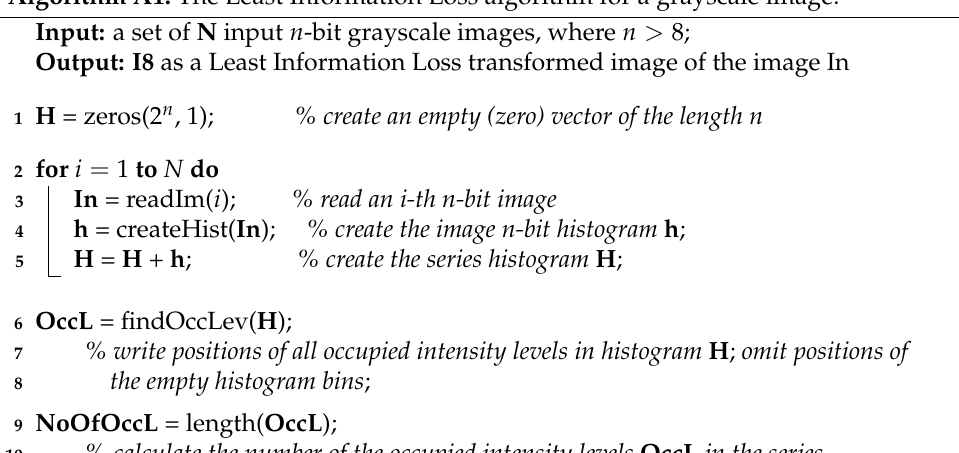
Algorithm A1: The Least Information Loss algorithm for a grayscale